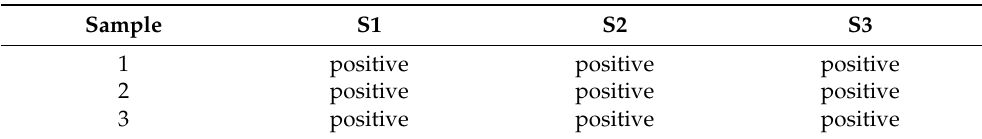
Table 2. Determination of proanthocyanidins’ presence. EtOH: 80–20% EtOH-water acidified with 5% acetic acid (S1); MeOH: 80–20% MeOH-water acidified with 5% acetic acid (S2); ethyl acetate acidified with 5% acetic acid (S3).